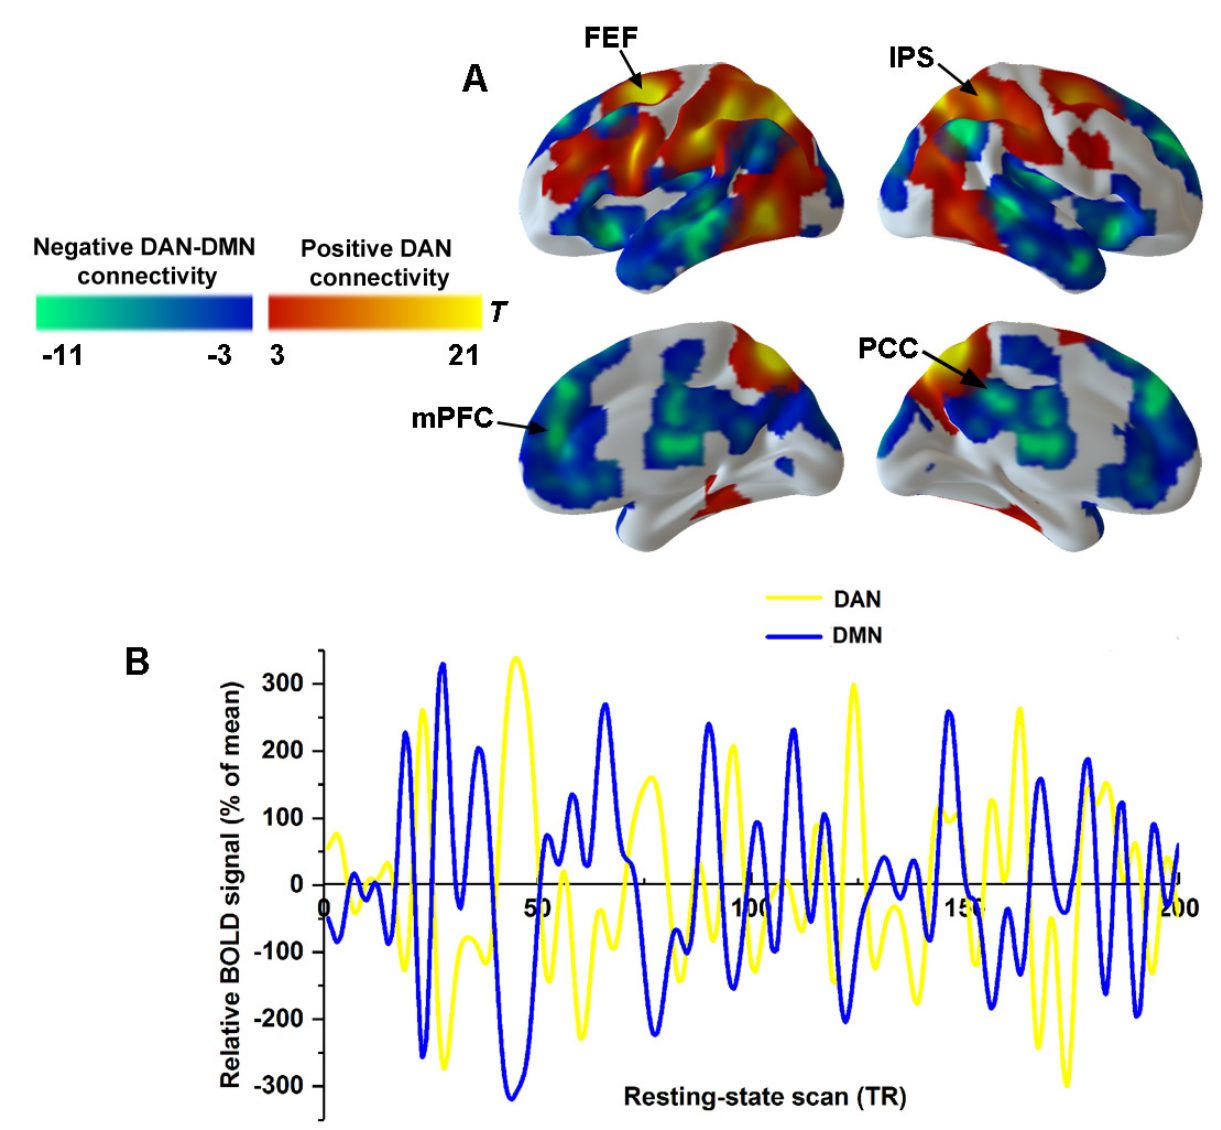
Figure 3. Anticorrelation between DAN and DMN. ( A ) Seed-based functional connectivity for pre-injection section was used to derive spatial masks for DAN (warm color) and DMN (cold color). ( B ) Single volunteer time series are illustrated for DAN connectivity (yellow) and DMN connectivity (blue). Abbreviations: PCC, posterior cingulate cortex; mPFC, medial prefrontal cortex; IPS, intraparietal sulcus; FEF, frontal eye fields; DAN, dorsal attention network; DMN, default mode network.